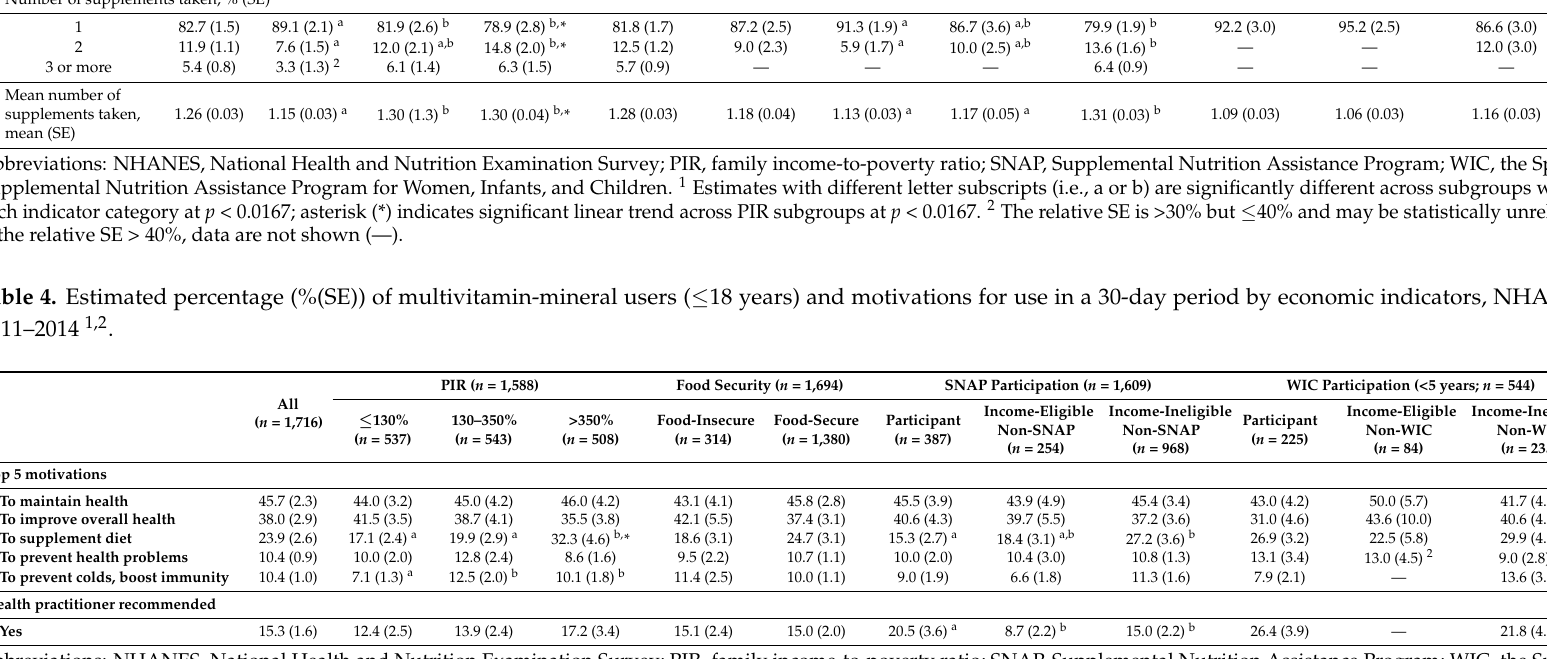
Abbreviations: NHANES, National Health and Nutrition Examination Survey; PIR, family income-to-poverty ratio; SNAP, Supplemental Nutrition Assistance Program; WIC, the Special Supplemental Nutrition Assistance Program for Women, Infants, and Children. 1 Estimates with different letter subscripts (i.e., a or b) are significantly different across subgroups within each indicator category at p < 0.0167; asterisk (*) indicates significant linear trend across PIR subgroups at p < 0.0167. 2 The relative SE is >30% but ≤ 40% and may be statistically unreliable. If the relative SE > 40%, data are not shown